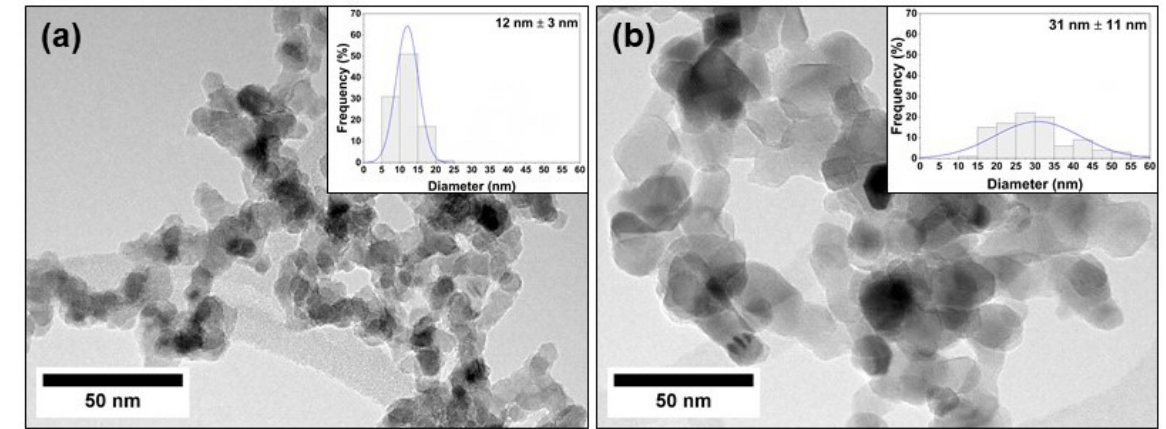
Figure 1. TEM images of annealed Cu/TiO 2 -He NPs ( a ) and Cu/TiO 2 -Ar NPs ( b ); insets refer to associated size distribution histogram fitted with the normal function.